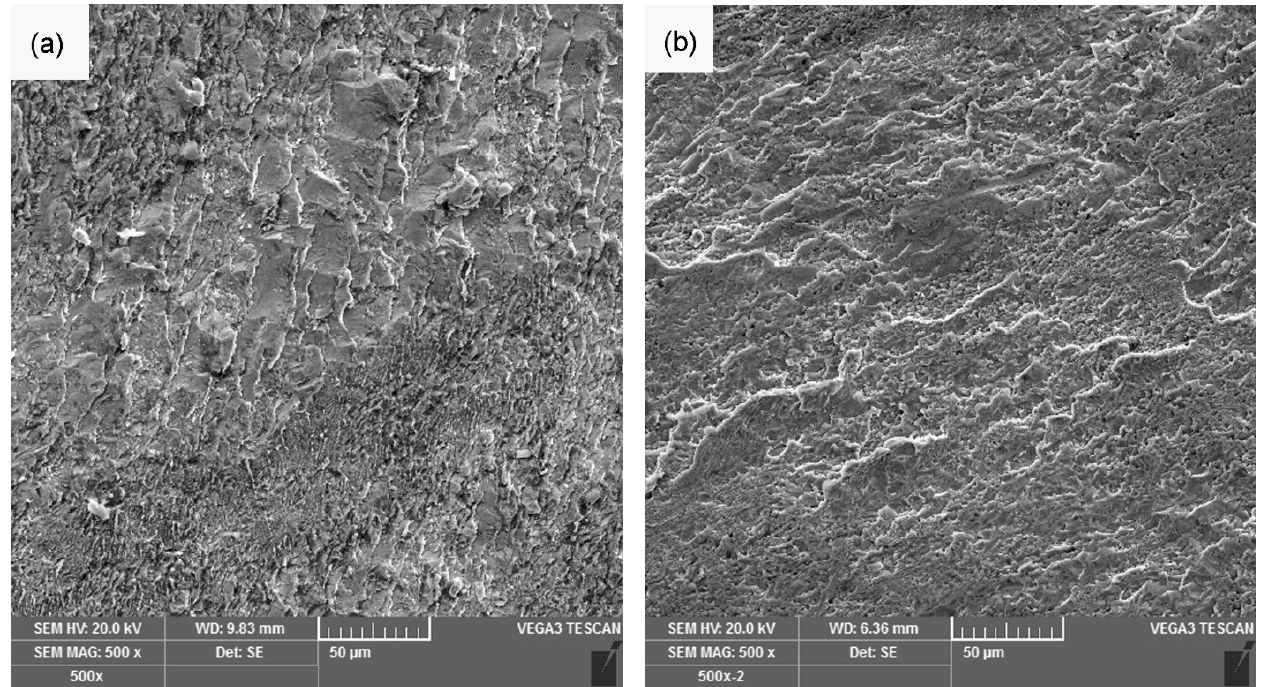
Figure 13. Fracture surfaces of the dissimilar Ti-6Al-4V/Nitinol welded joints in the ( a ) as-welded and ( b ) PWHT conditions.